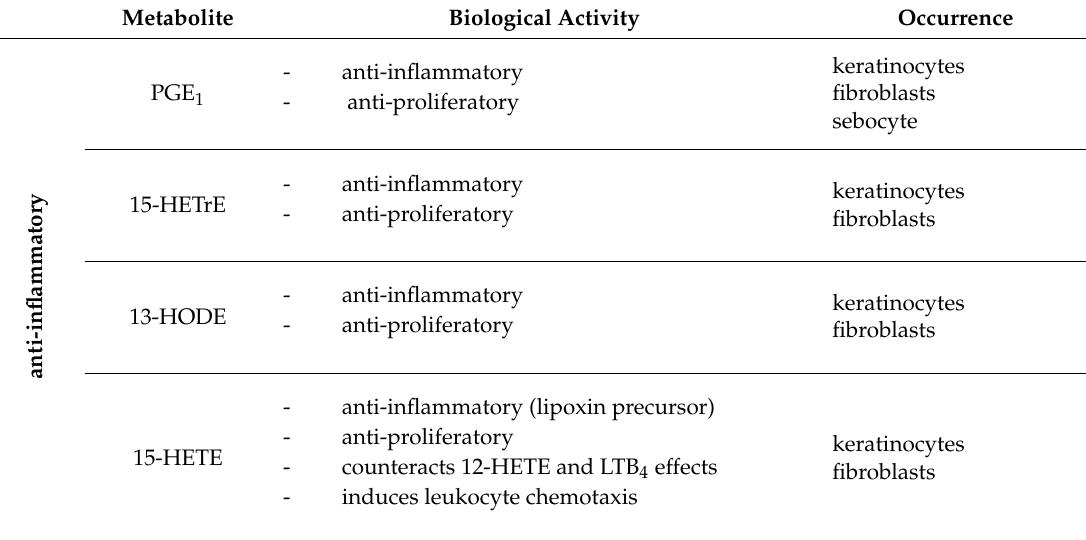
Table 5. Biological effect and occurrence of selective eicosanoids